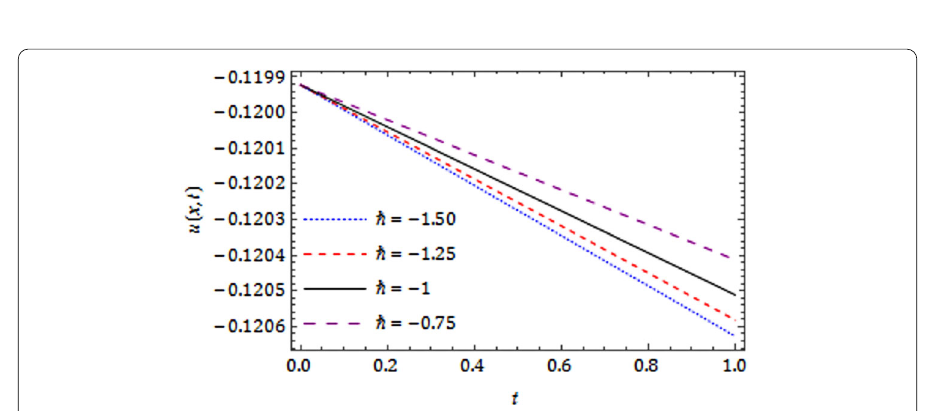
Figure 13 Response of v ( x , t ) with t at diverse α when ω = 0.005, (cid:13) = 0.1, c = 10, n = 1, (cid:2) = –1 and x = 1 for Example